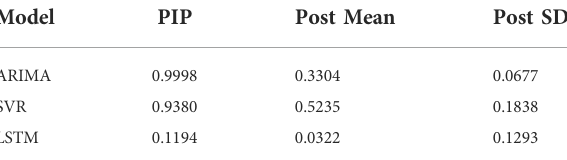
TABLE 2 Results of